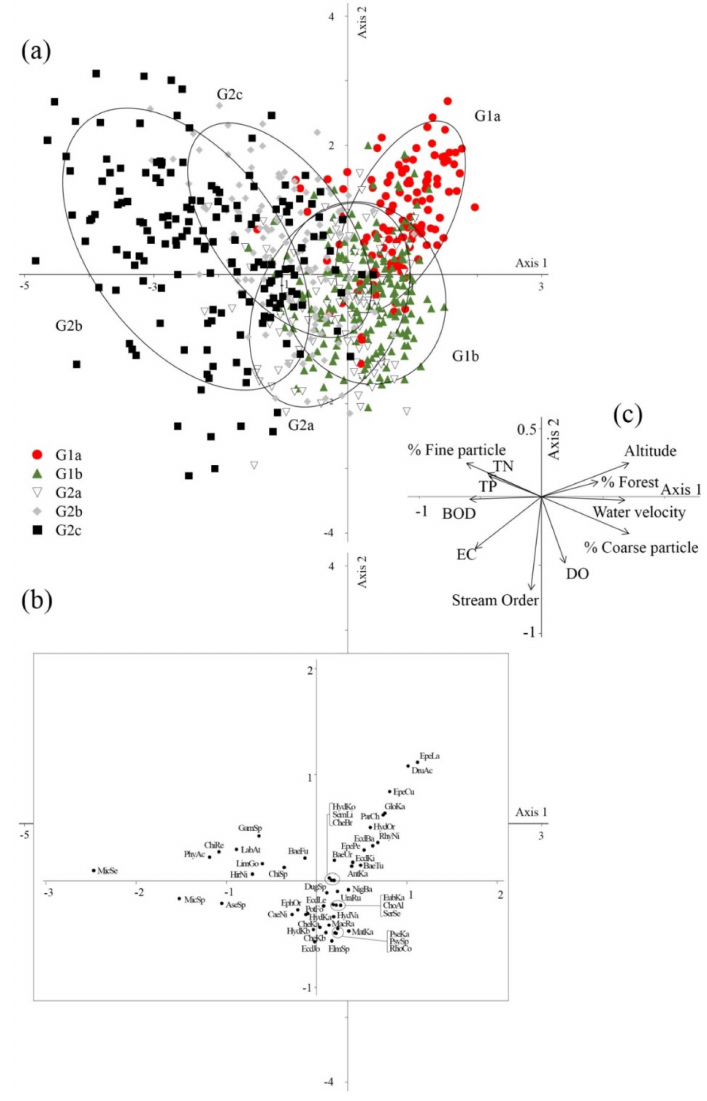
Figure 4. Ordination plots constructed by canonical correspondence analysis for all sampling sites ( n = 720). The plots present the ordination of sampling sites ( a ) and macroinvertebrates ( b ) with relative contributions of environmental variables ( c ) for the first two axes. Only species contributing >0.2% to total abundance were included. The summary of ordination results is presented in Table 4 and the codes for each taxon are shown in Appendix Table